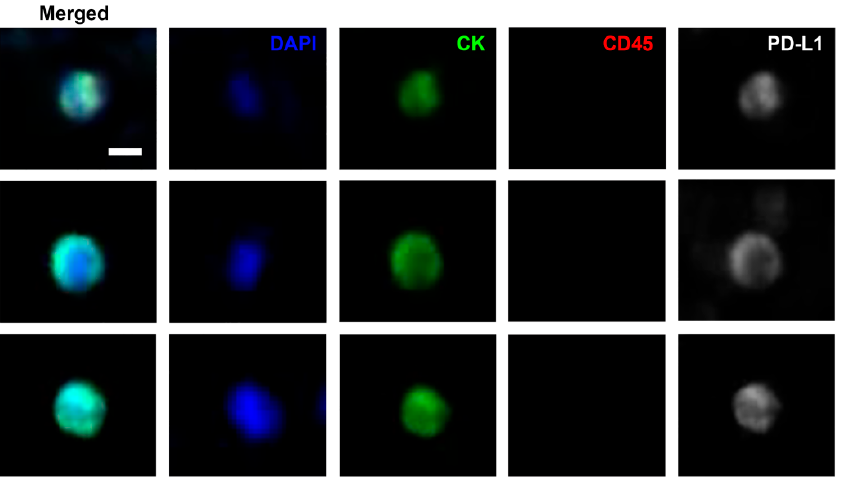
Figure 2. Immunofluorescence staining of representative programmed cell death ligand 1 (PD-L1, white) circulating cancer cells obtained using the IsoFlux system. Cancer cells fulfilled the criteria for circulating tumor cells, including nucleated (blue), CK-positive (green), and CD45-negative (non-red) cells. Scale bar, 5 µm. Table 1. Demographic and clinical features of patients with urothelial carcinoma.